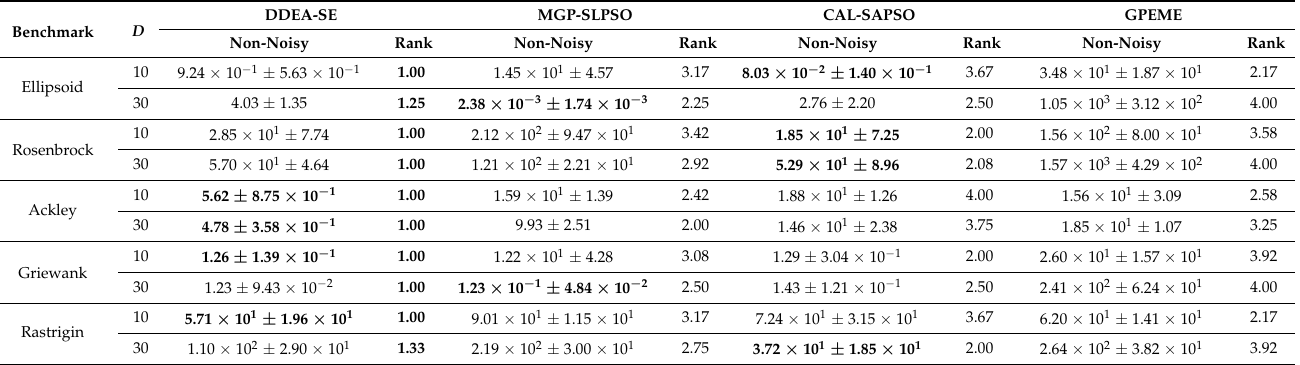
Table 4. Average fitness of DDEAs on different benchmark problems in non-noisy environments and the rank of experimental results in noisy environments. The best results are in